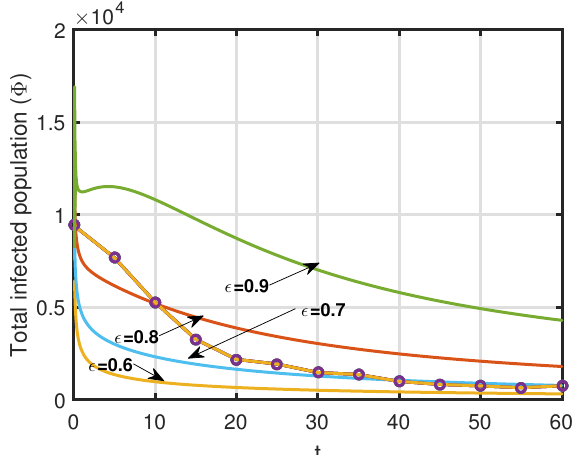
Figure 9. Variation of total infected population ( I + C ) and infected cases with co-morbidity when ε =